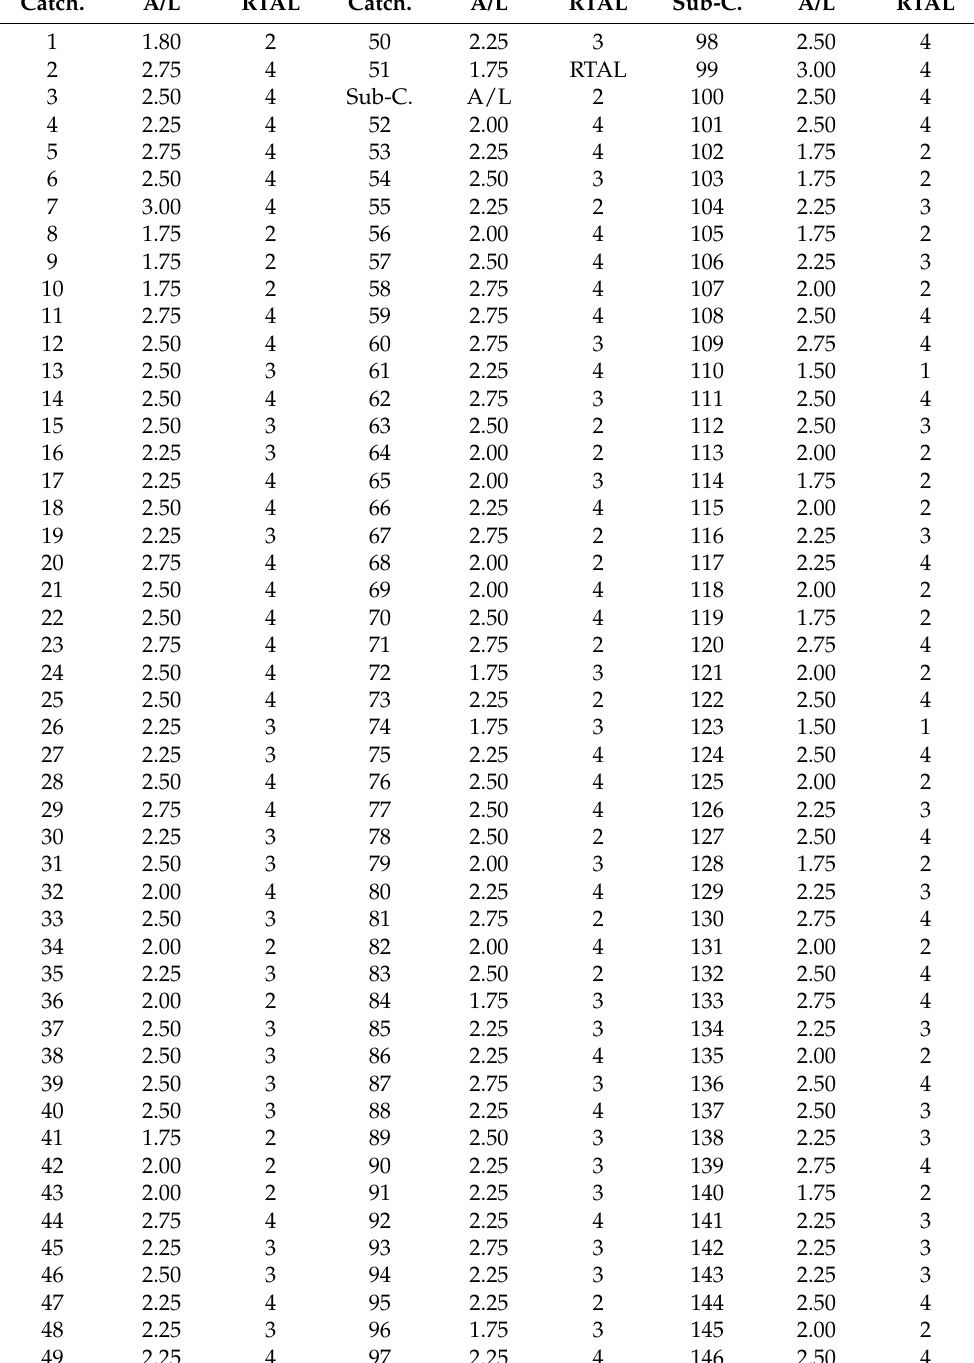
Table 1. Classification of the RTAL (relative tectonic activity levels) in Wadi Al-Arish.